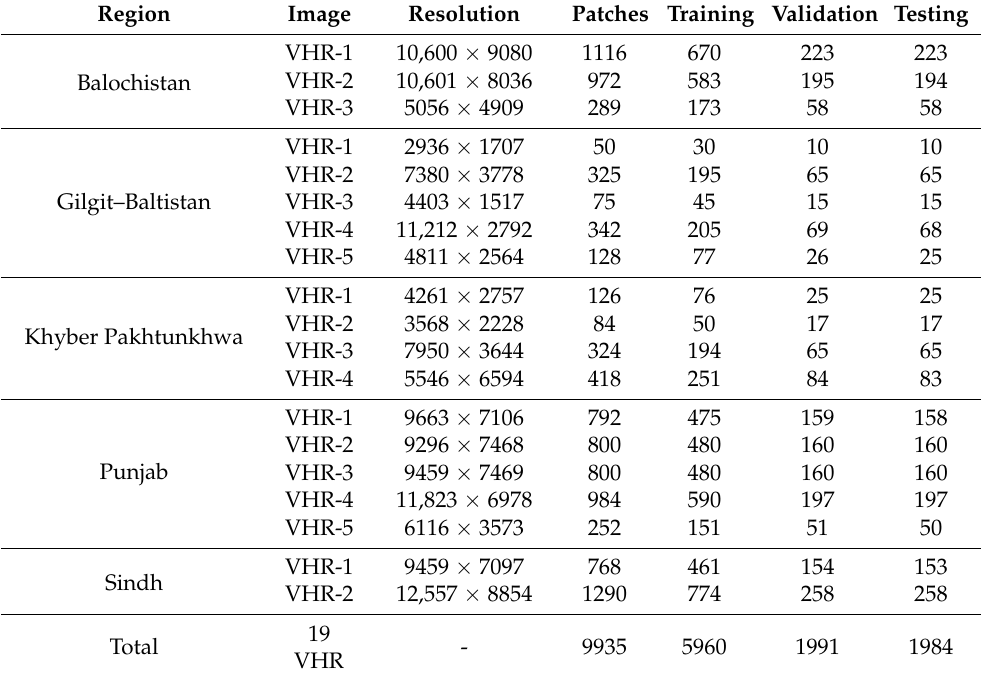
Table 1. Dataset details and specifications.